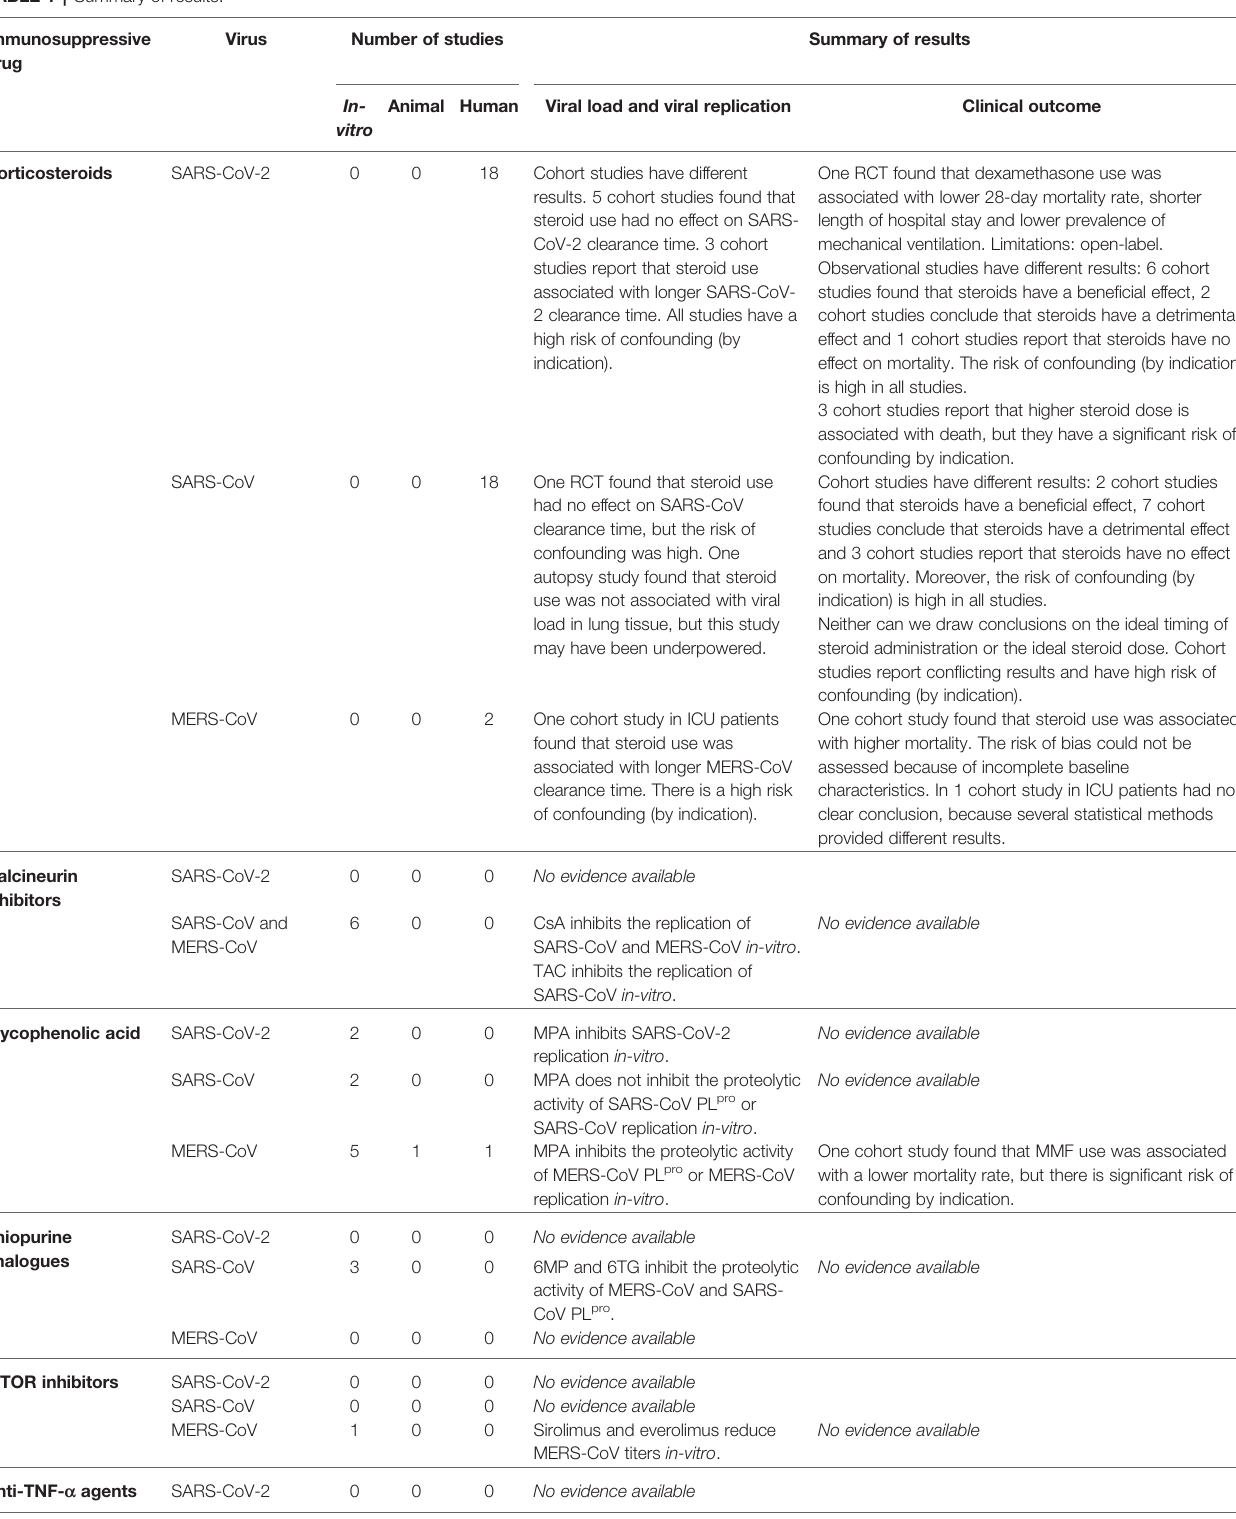
TABLE 1 | Summary of